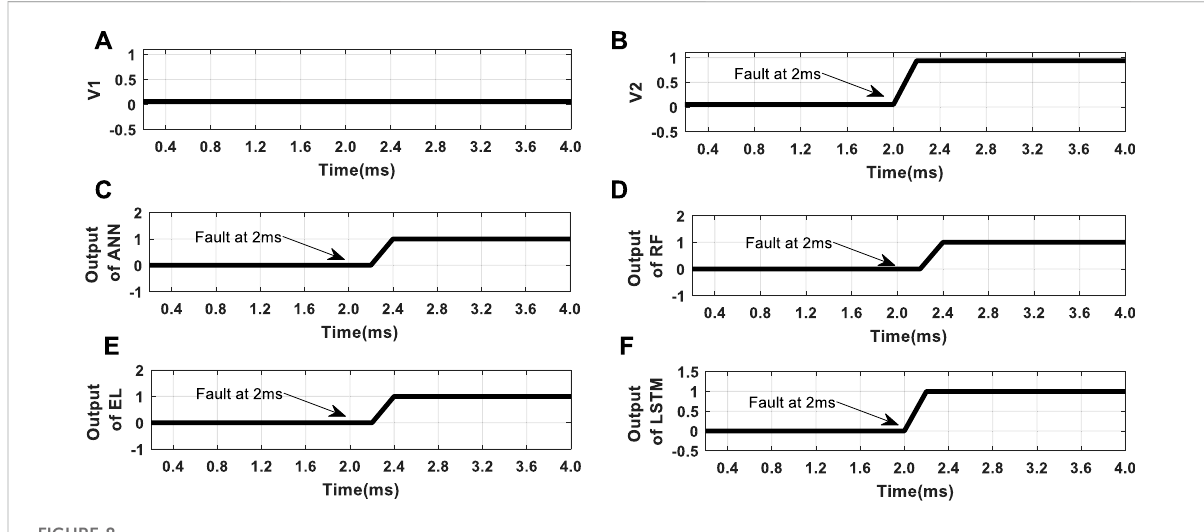
FIGURE 8 (A) Voltagefeaturesofpole1. (B) Voltagefeaturesofpole2. (C) OutputofANN. (D) OutputofRF. (E) OutputofEL. (F) OutputofLSTMduringP2G fault at 1,000 km with R = 0 Ω at 2 ms time.